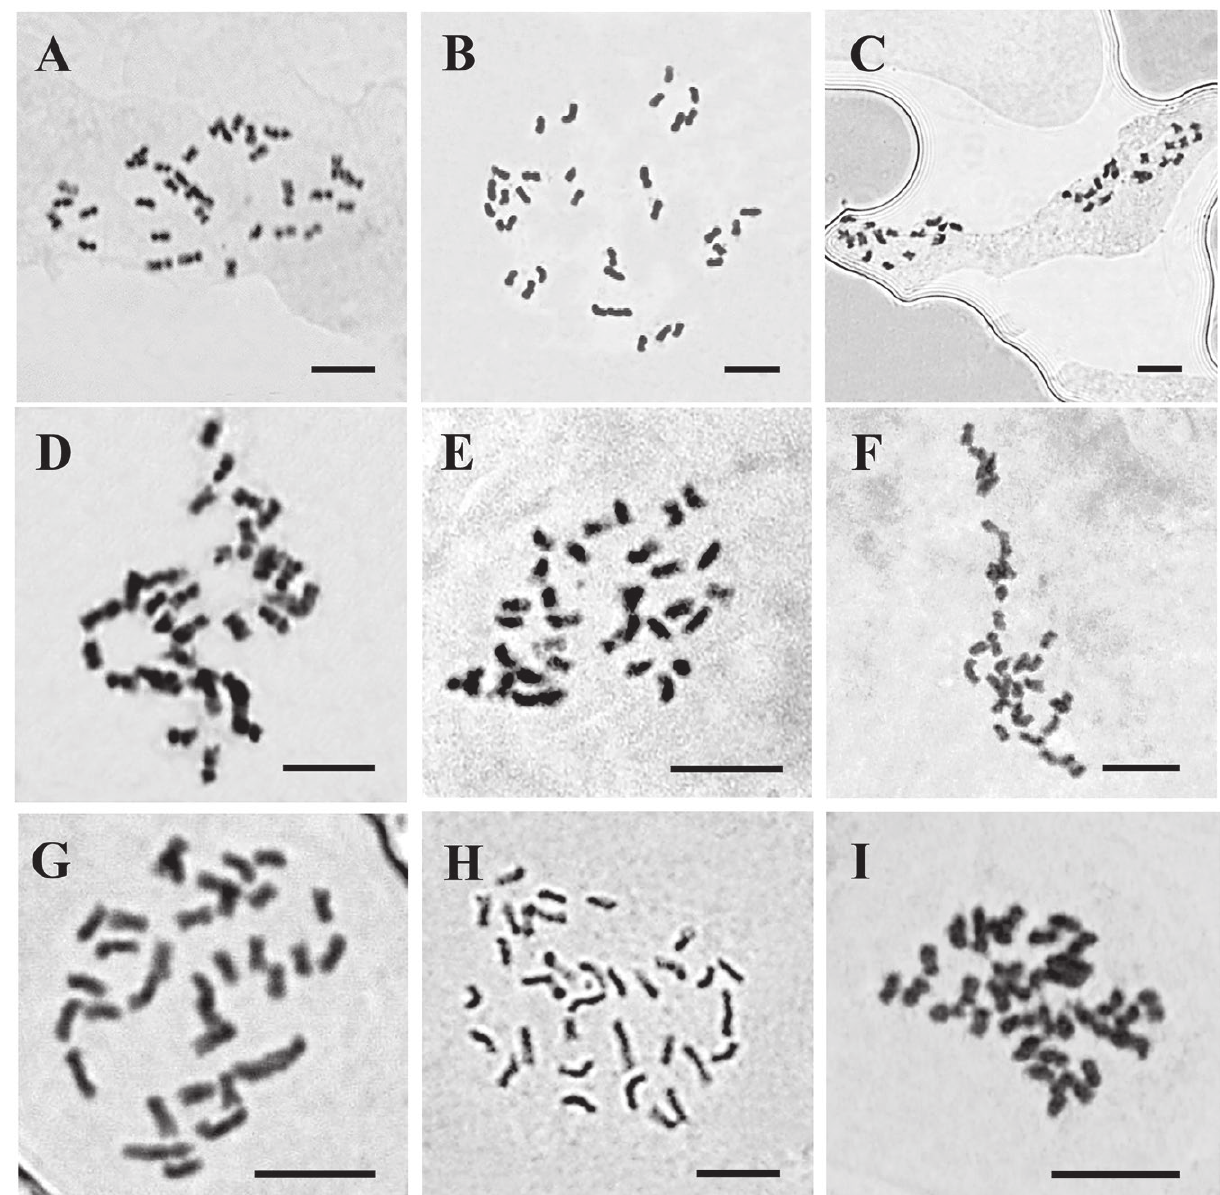
Figure 1. Somatic chromosomes at the metaphase stage in root tip cells of Sorbus taxa. A- S. alnifolia ; B- S. alnifolia var. angulata ; C- S. alni- folia var. lobulata ; D- S. dunnii ; E- S. folgneri ; F- S. hemsleyi ; G- S. lushanensis ; H- S. ochracea ; I- S. yuana . Scale bar = 5